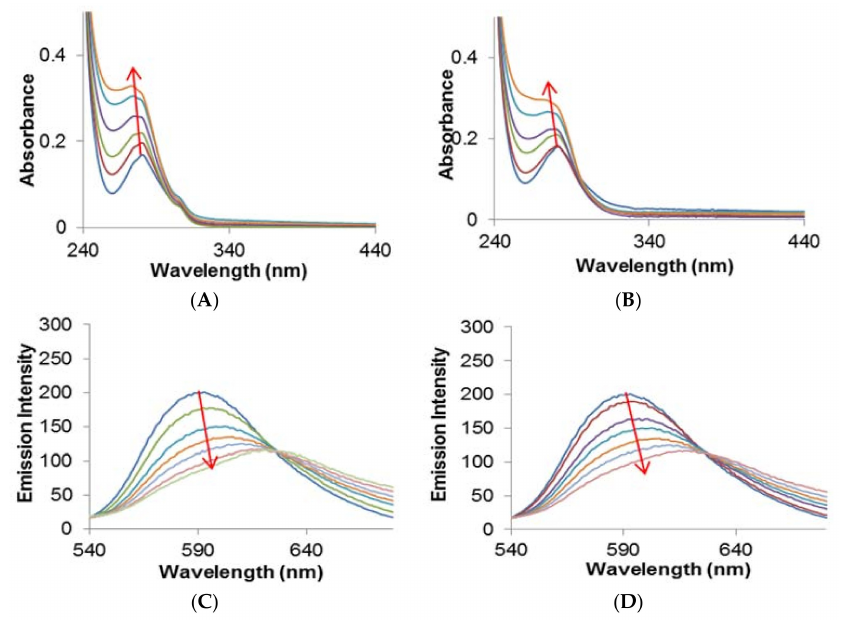
Figure 4. Absorption spectra of ( A ) complex 1 ; and ( B ) complex 2 with CT-DNA. Fluorescence quenching spectra of ( C ) complex 1 ; and ( D ) complex 2 with EthBr-DNA adduct. Both experiments were carried out in 5 mM Tris-HCl/50mM NaCl buffer, pH = 7.5, at room temperature. The spectra in different colors represent the effect of increasing concentrations (symbolized by an arrow) of complexes 1 and 2 on the studied spectroscopic properties.